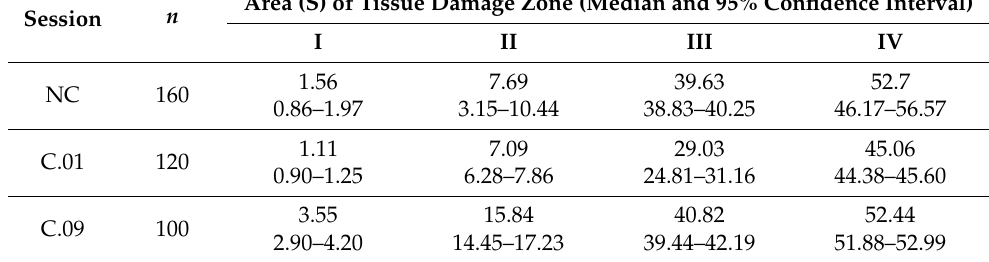
Table 2. Areas (S) of the tissue damage zones calculated as their medians and confidence intervals. Session